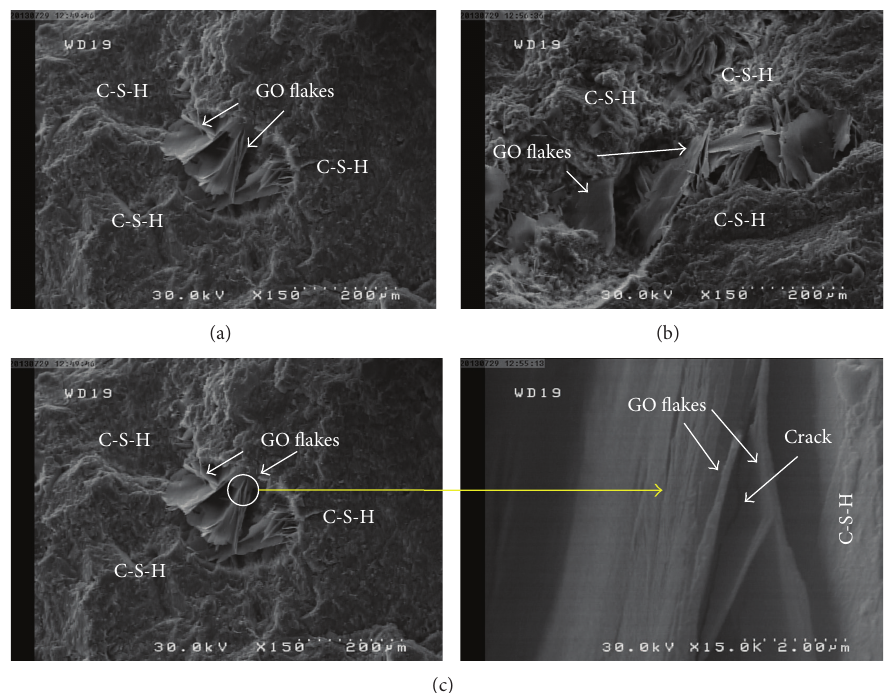
Figure 11: FE-SEM images of cement mortar containing 1.5wt% GO at scales of 200 𝜇 m after 28 days of curing, showing the nucleation of C-S-H by the GO flakes and its formation along them ((a) and (b)). FE-SEM images of cement mortar containing 1.5wt% GO at scales of 200 and 2.0 𝜇 m after 28 days curing, showing microcracks on a GO flake under tensile stresses (c).